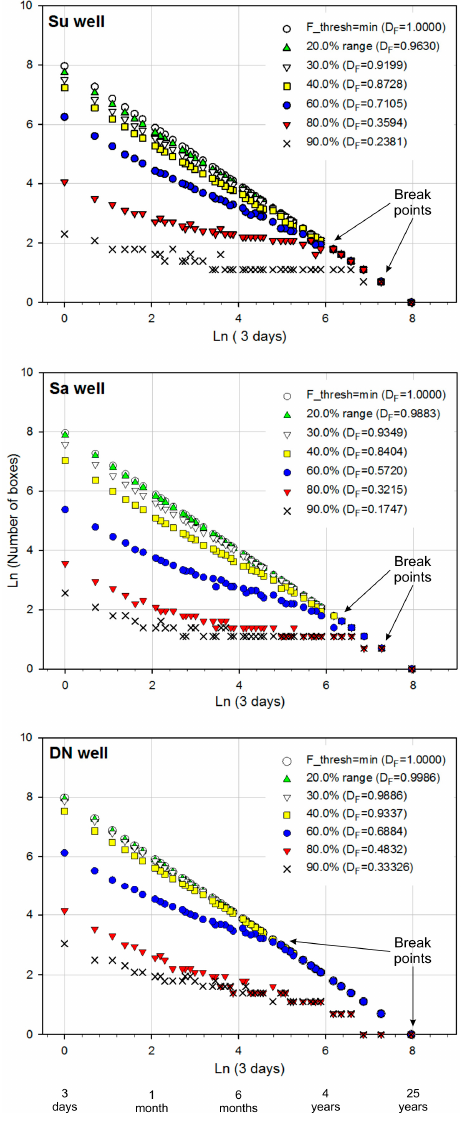
Figure 14. Su, Sa, DN outcomes related to piezometric levels; Fractal dimensions related to different F_threshold events.